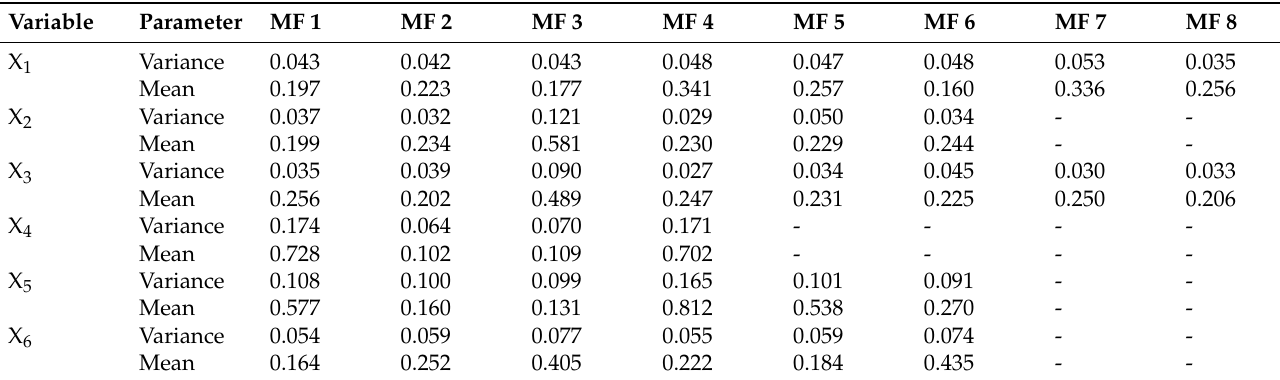
Figure 7. Membership functions of the input variables. Table 4. The parameters of the membership functions.